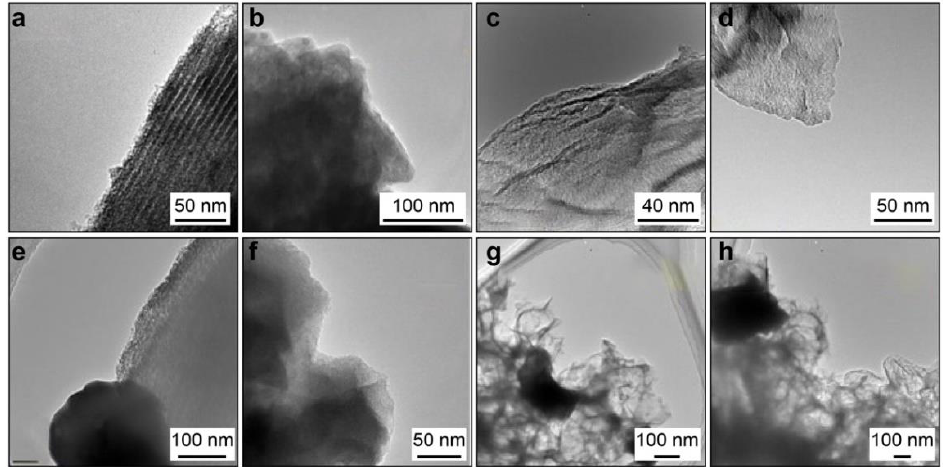
Figure 1. Transmission electron microscopy (TEM) images of ( a ) CMK-3, ( b ) C320, ( c ) C500, ( d ) C642, ( e ) POM / CMK-3, ( f ) POM / C320, ( g ) POM / C500, and ( h ) POM / ( e ) POM/CMK-3, ( f ) POM/C320, ( g ) POM/C500, and ( h ) POM/C642.